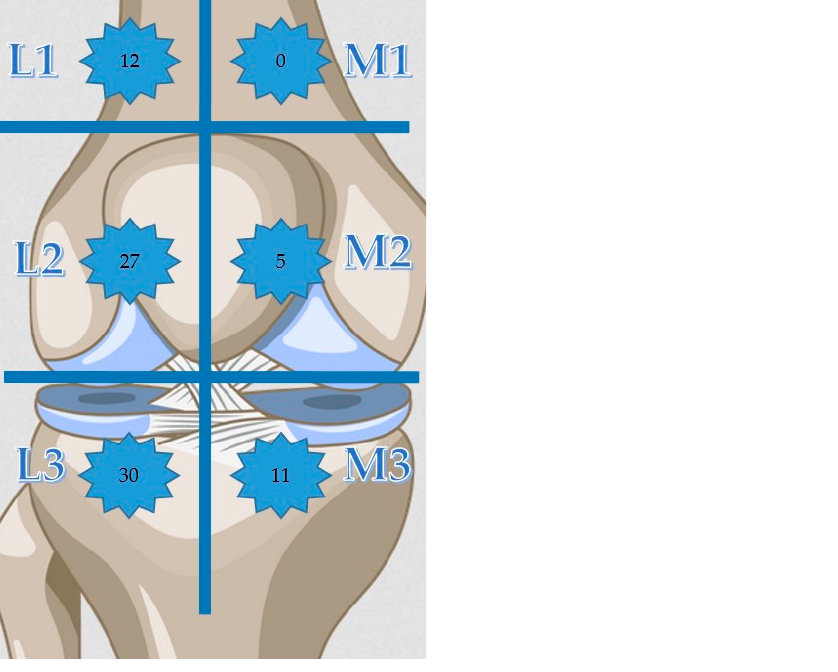
Figure 1. Distribution of numbness. Note L: lateral, M: medial, suprapatellar L1-M1, patellar L2-M2, infrapatellar L3-M3.